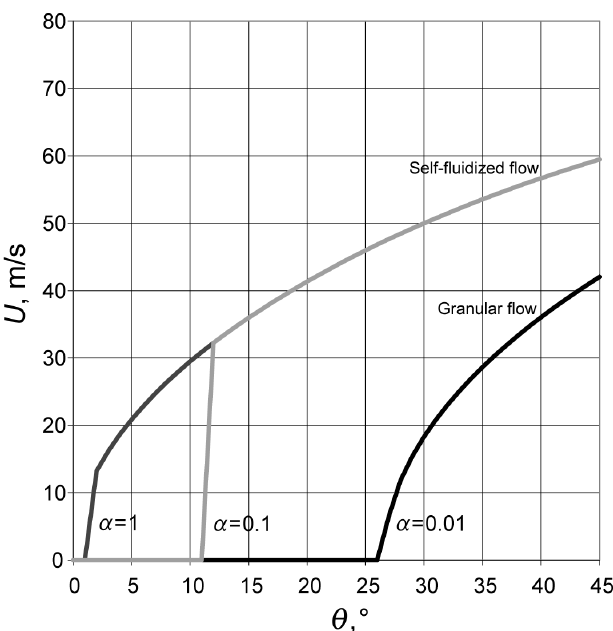
Fig. 5. Implementation of the criterion: computation of the front speed. Depth of the current: h = 5 m; angle of internal friction θ 0 =